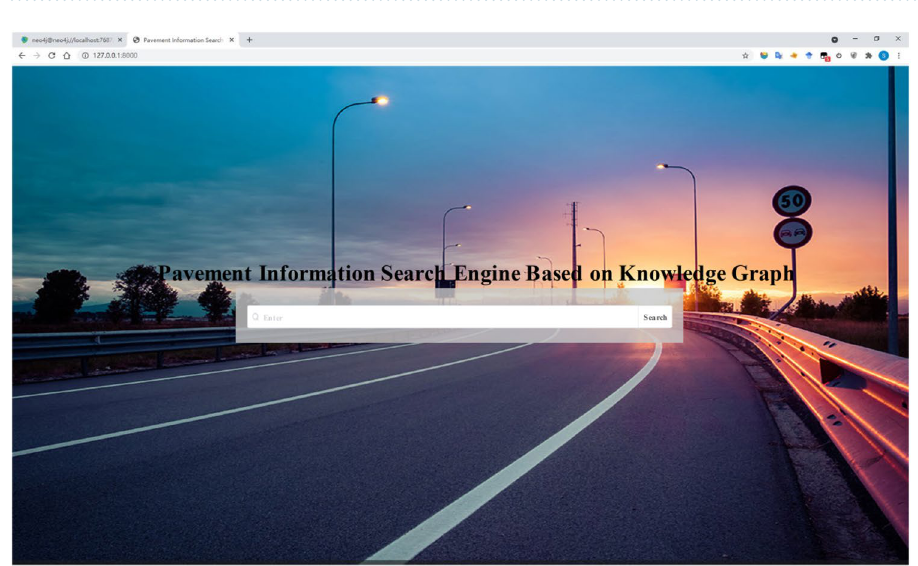
Figure 7. The pavement information search engine based on knowledge